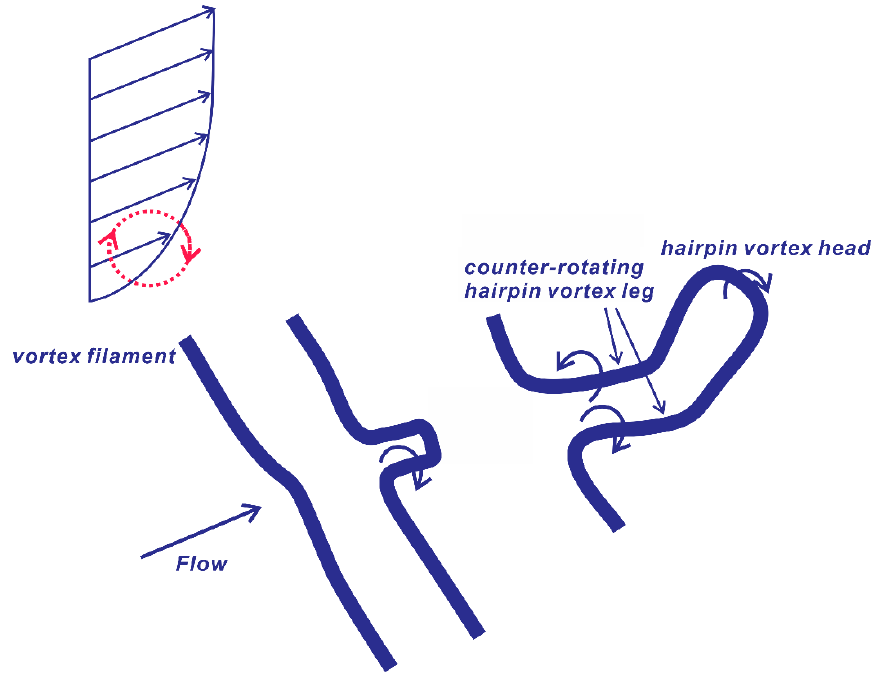
Figure 7. Development of the hairpin vortex (reproduced from [24]).